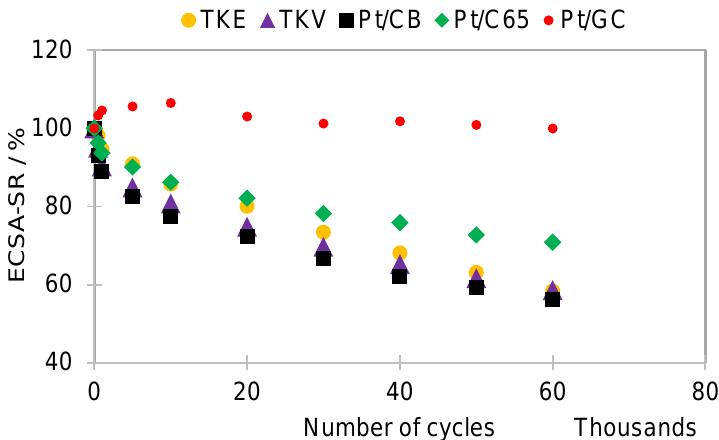
Figure 2. Changed electrochemical active surface area (ECSA) survival rates of the supported catalysts while potential cycling between 1.0 and 1.5 V vs. RHE at 0.5 V s −1 voltage scan rate at room temperature (RT).